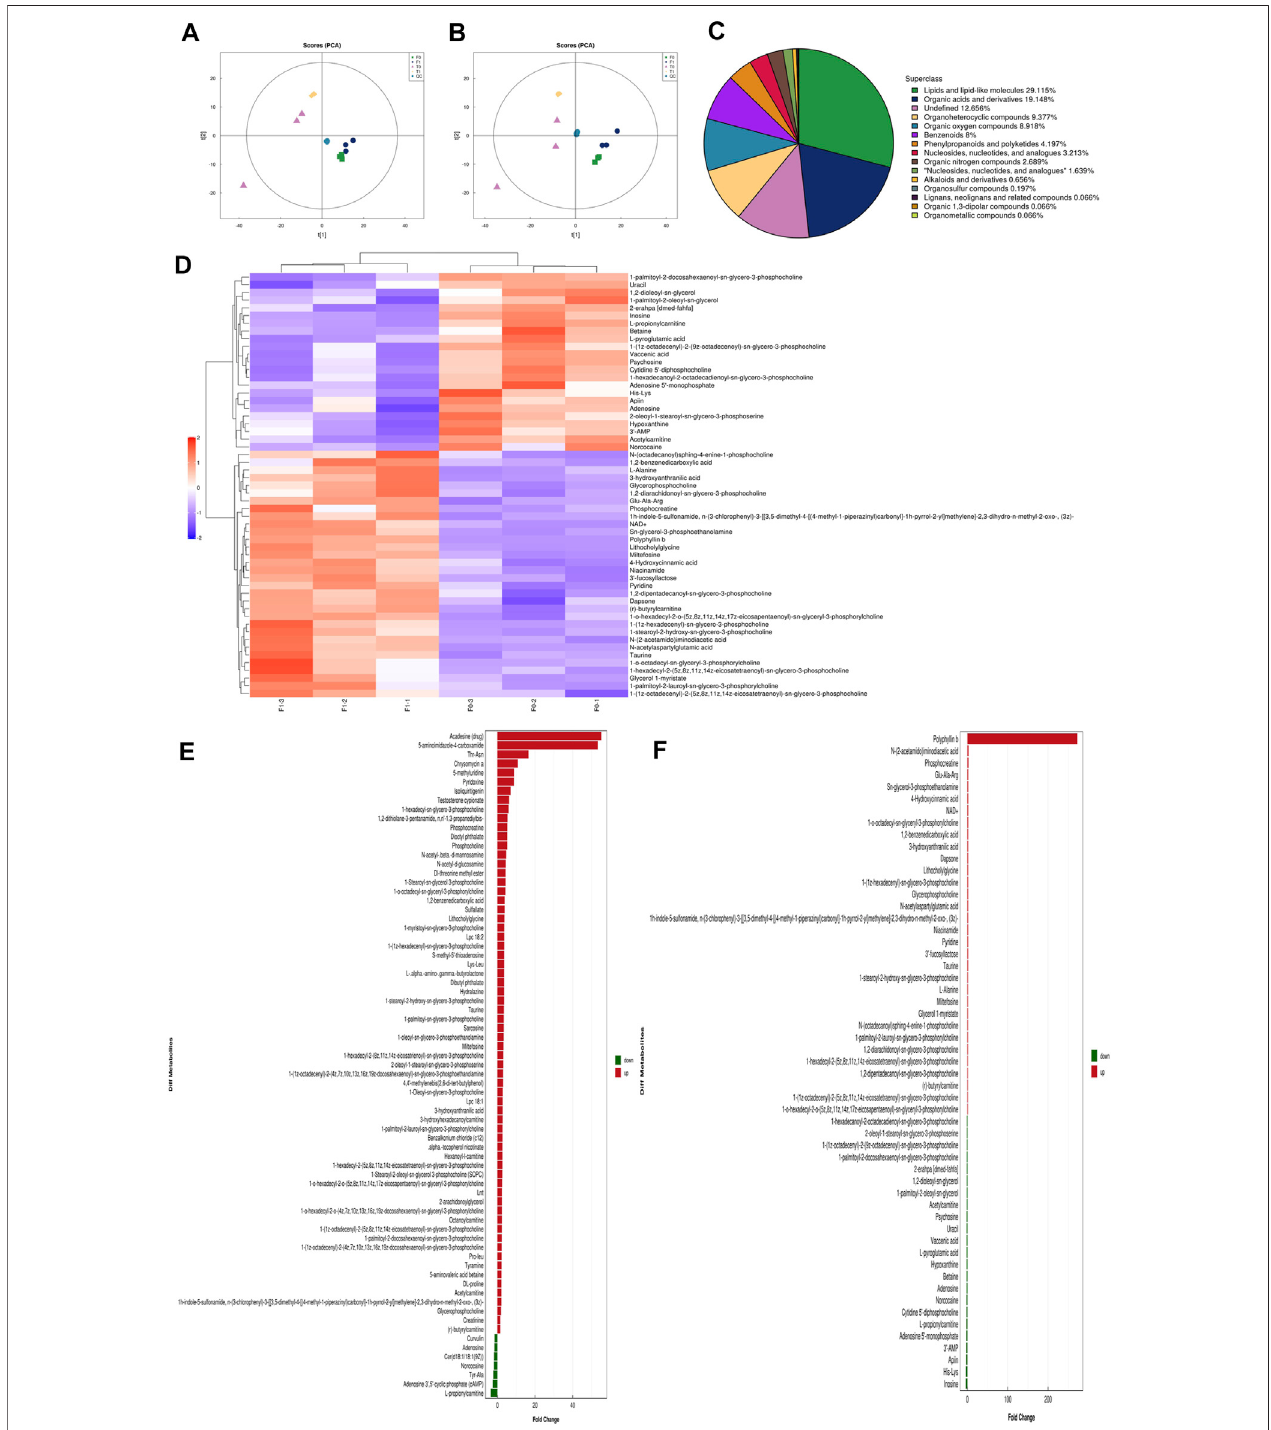
FIGURE7| High-resolutionuntargetedmetabolomicsanalysis. (A) PCAanalysisdiagramofpositiveionmodelpopulationsample. (B) PCAanalysisdiagramofthe total sample of anion mode. (C) The proportion of the number of various metabolites. (D) Hierarchical cluster heat map of signi fi cant differential metabolites. (E) Histogram of the identi fi ed multiple changes of signi fi cant differential metabolites, and multiple analyses of signi fi cant differential metabolite expression in positive ion mode. (F) Histogram of the identi fi ed multiple changes of signi fi cant metabolic differences and multiple analyses of metabolite expression in negative ion mode. All the experiments were carried out three times. Each data represent the mean ± SD of three independent experiments (* p < 0.05; ** p < 0.01; *** p < 0.001 vs the control group).